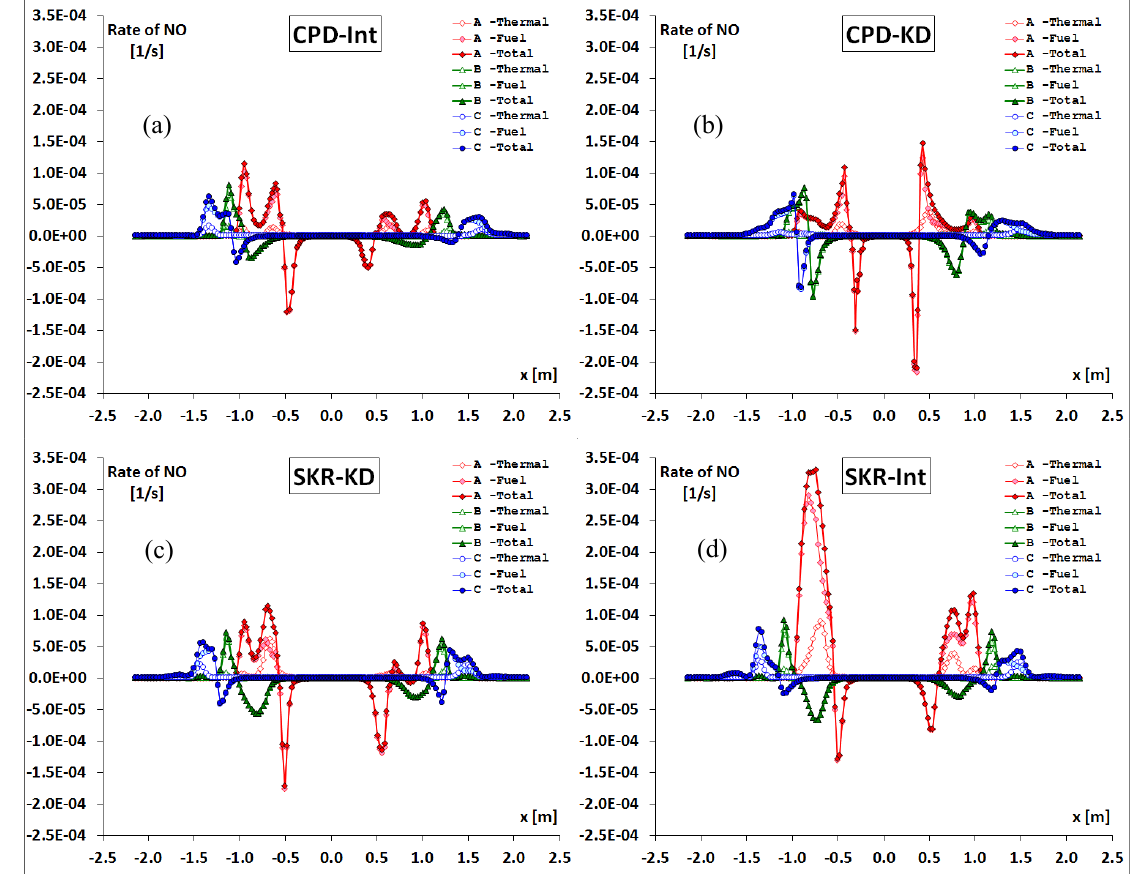
Figure 11. NO rate distribution evaluated at Traverses A, B and C according to the different CFD models.